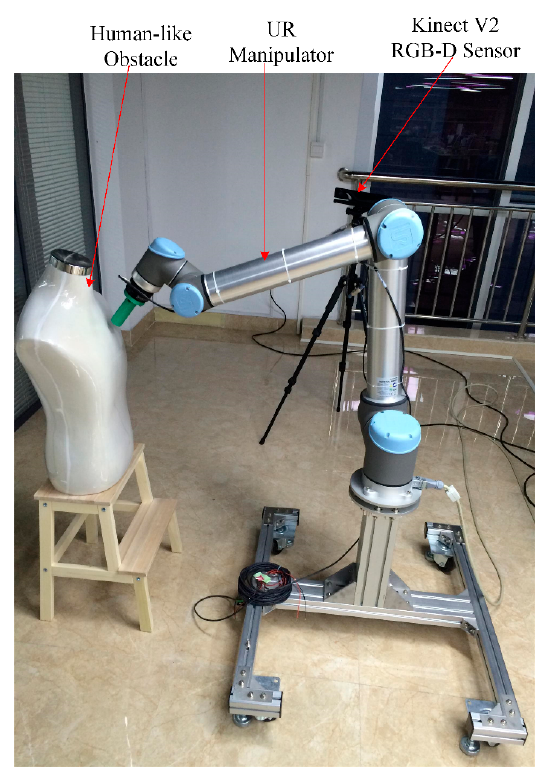
Figure 5. Experiment setup. UR represents Universal Robots.